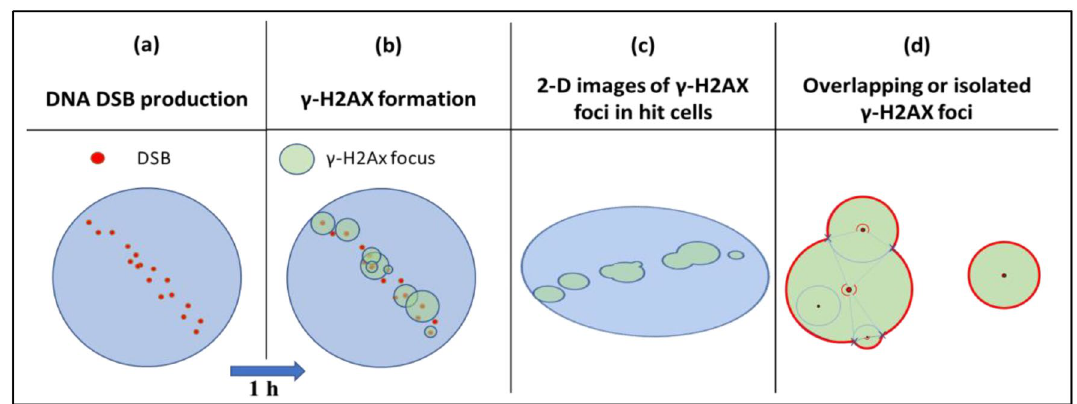
Figure 4. Illustration of γ-H2AX focal image analysis: ( a ) simulating DSB productions, ( b ) determining the sizes of γ-H2AX foci, ( c ) viewing the 2D images of γ-H2AX foci after cell rotation, and ( c ) identifying overlapping or isolated focal